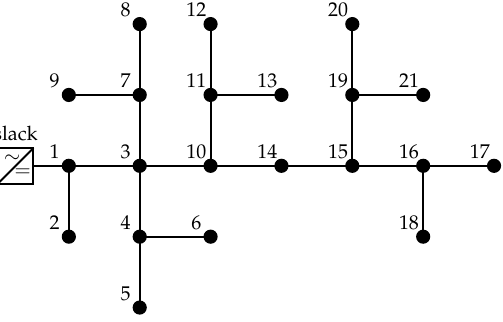
Figure 3. Grid configuration of the 21-bus system. The 21-bus grid has a radial configuration with a voltage output in the slack node of ± 1 kV and with 0 V in the neutral point. The complete parametric information for this test feeder is listed in Table 2. Table 2. Parametric information of the 21-bus system (all powers are in kW). Node j Node